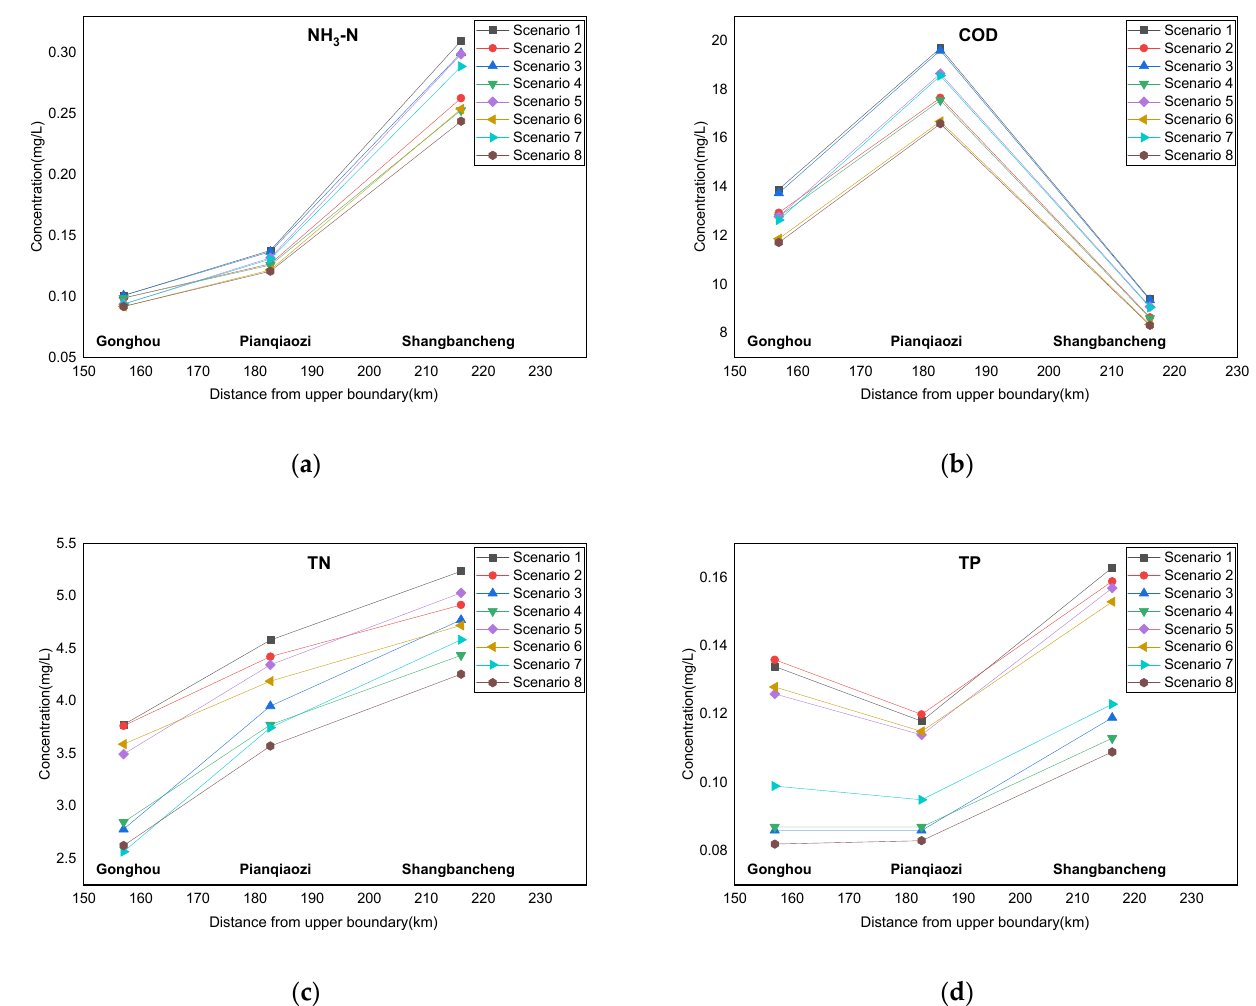
Figure 5. Change in NH 3 -N ( a ), COD ( b ), TN ( c ), and TP ( d ) concentration.